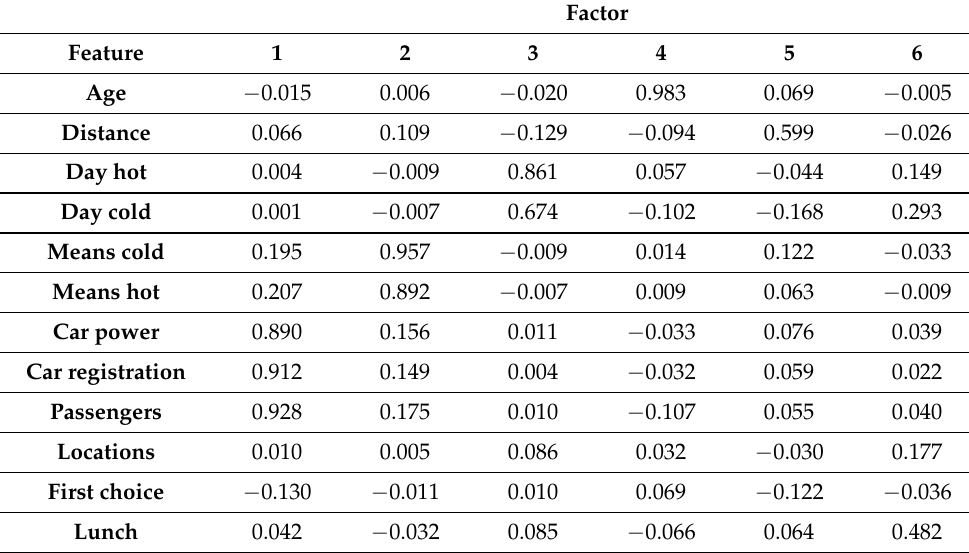
Table 3. Factor loadings.